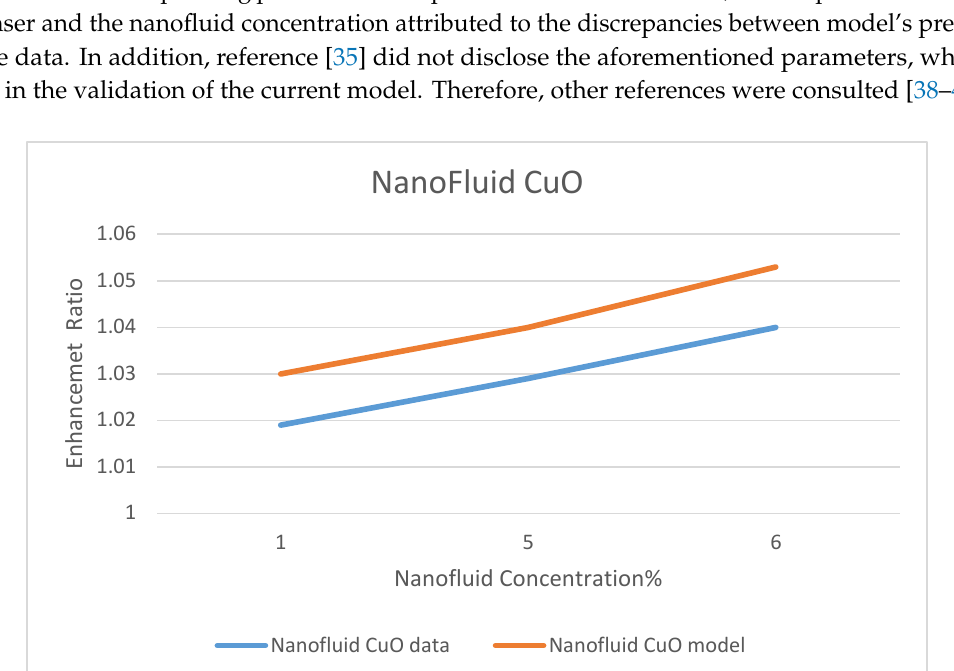
Figure 33. Comparison between model and data of Bellos and Tzivanidis [35] as in text is (Al 2 O 3 ) and applies to all other Figures. Marefatoi et al. [31] presented an optical and thermal analysis of parabolic trough solar collector (PTC) and evaluated the performance of the PTC, using four cities with different weather conditions. The analysis was performed using MATLAB software and shows an average annual thermal efficiency of 13.91%. Also, their work concluded that using the nanofluids CuO, SiO2 and Al 2 O 3 as heat transfer fluid increased the heat transfer and system efficiency under average solar radiations of 344 w/m 2 . Those results and conclusions were compared to our model’s predictions under similar average solar radiations and it was found that our prediction of the system efficiency was, on average, 13.15%, compared to 13.91% reported by reference [31]. In addition, our model predictions were in agreement with the results of reference [31] that nanofluids; CuO, SiO 2 and Al 2 O 3 enhanced the heat transfer. Other comparisons between our model’s prediction for the convection heat transfer coefficient and the data reported by Marefatoi et al. [31] on Al 2 O 3 and SiO 2 are presented in Figures 34 and 35,